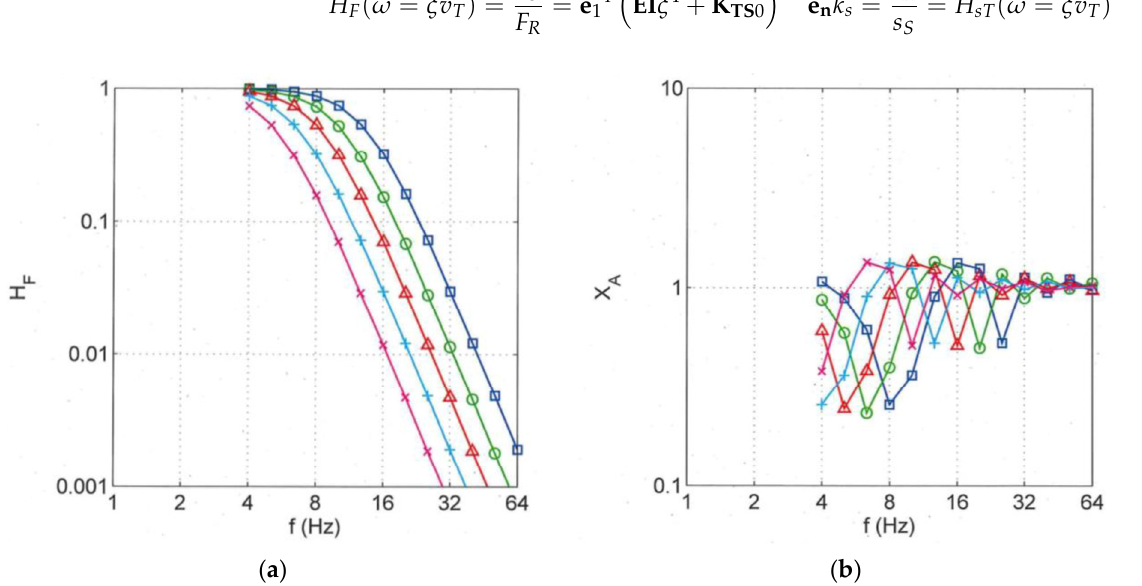
Figure 3. Spectra for the calculation of a standard ballast track with varying track support stiffness, ( a ) filter function of the track force, ( b ) axle-sequence spectrum of two axles of a bogie, train speed × 63, + 80, ∆ 100, ○ 125, and □ 160 km/h.